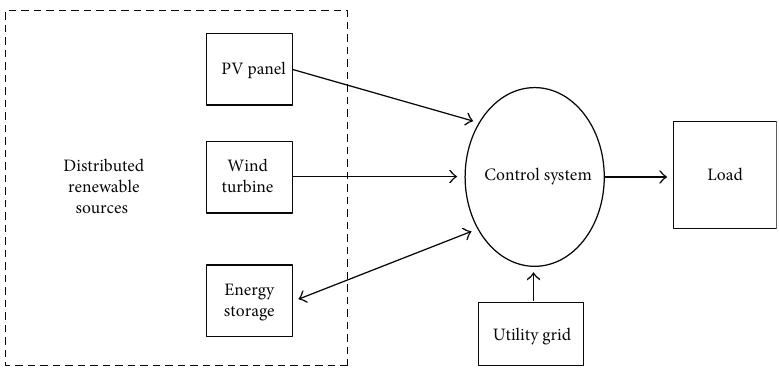
Figure 3: Distributed energy